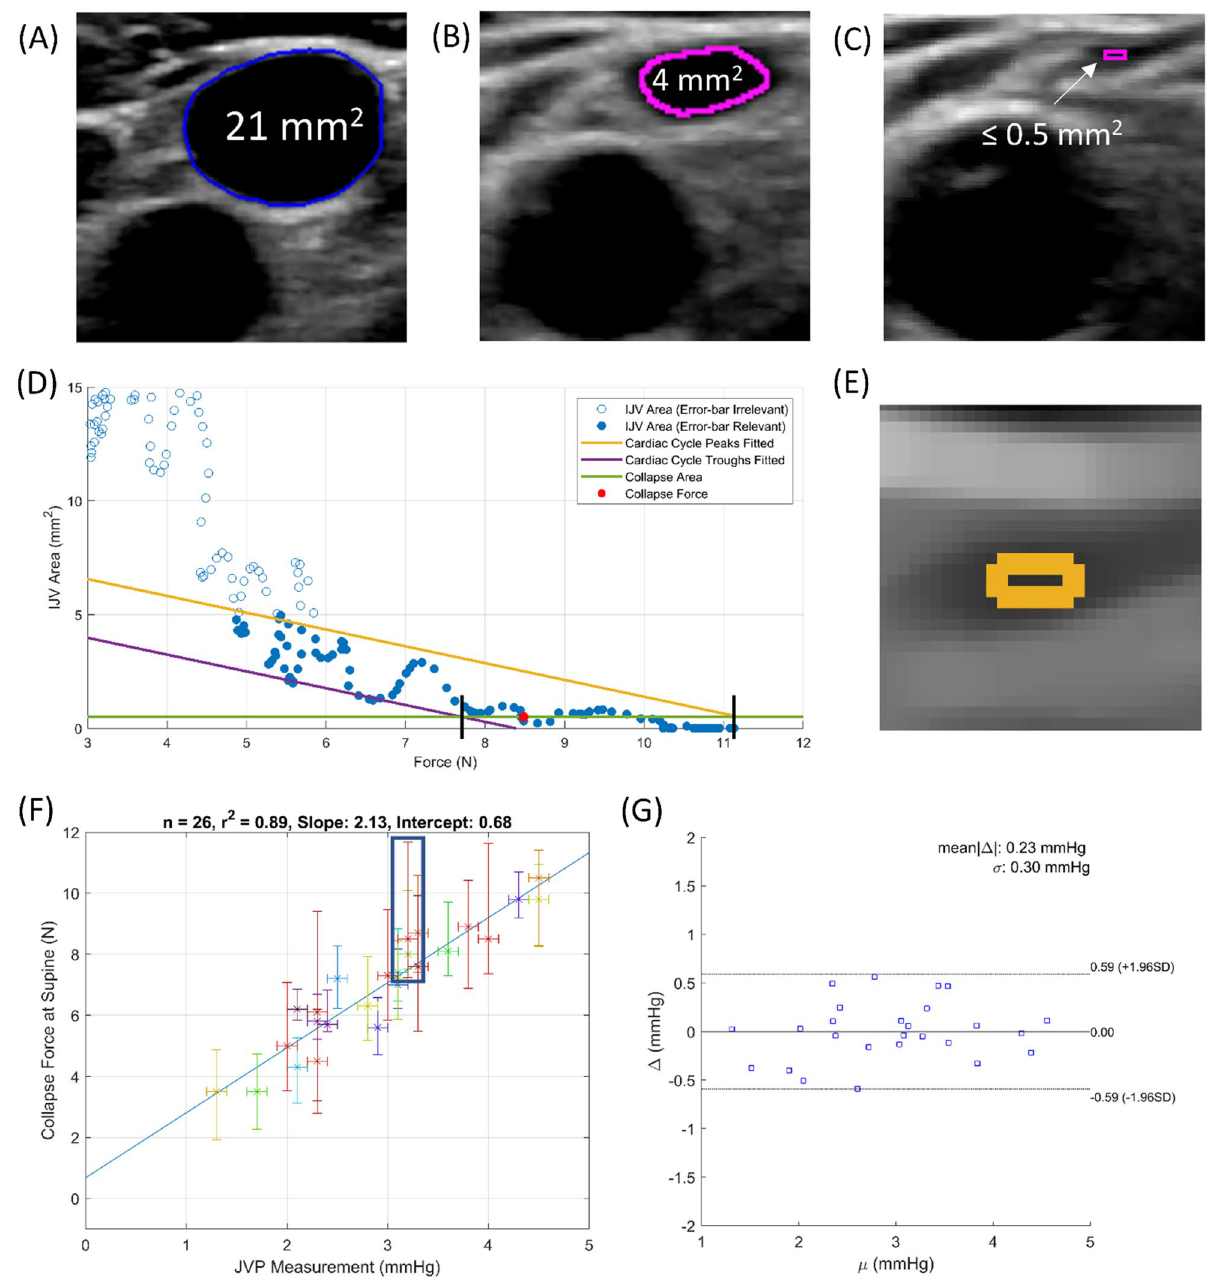
Figure 2. ( A ) Segmentation of an open IJV in subject 21. The full segmentation algorithm is used. ( B , C ) Only the first region growing step is used. ( B ) Segmentation of an almost collapsed IJV in subject 21. ( C ) Segmentation of a collapsed IJV in subject 21. ( D ) Collapse force uncertainty contribution due to cardiac cycle in subject 21. Using points with area under 5 mm 2 , lines are drawn to estimate the collapse force at the minimum and maximum points of the cardiac cycle. ( E ) Collapse force uncertainty contribution due to segmentation in subject 21. Uncertainty pixels are shaded in gold. ( F ) Correlation with uncertainty of JVP height and supine collapse force. ( G ) Bland–Altman plot of predicted JVP based on collapse force compared to measured where A seg is the observed IJV area from segmentation and A mod is the IJV area found from running the forward finite element model for a given venous pressure guess. The superscript and subscript 2 indicate we are taking the square of the L2 norm. Figure 4E shows the IJV area waveform, the carotid area waveform, the applied external force, the relevant linear regression results from collapse force measurement to predict CVP, and the venous pres- sure waveform. We note that the venous pressure waveform has identical morphology to the IJV area waveform. The labeled elements of the waveform (a, c, x, v, y) refer to filling and emptying of the right atrium and opening and closing of the tricuspid valve. Supplementary Fig. 6 details the filtering of the carotid area waveform.